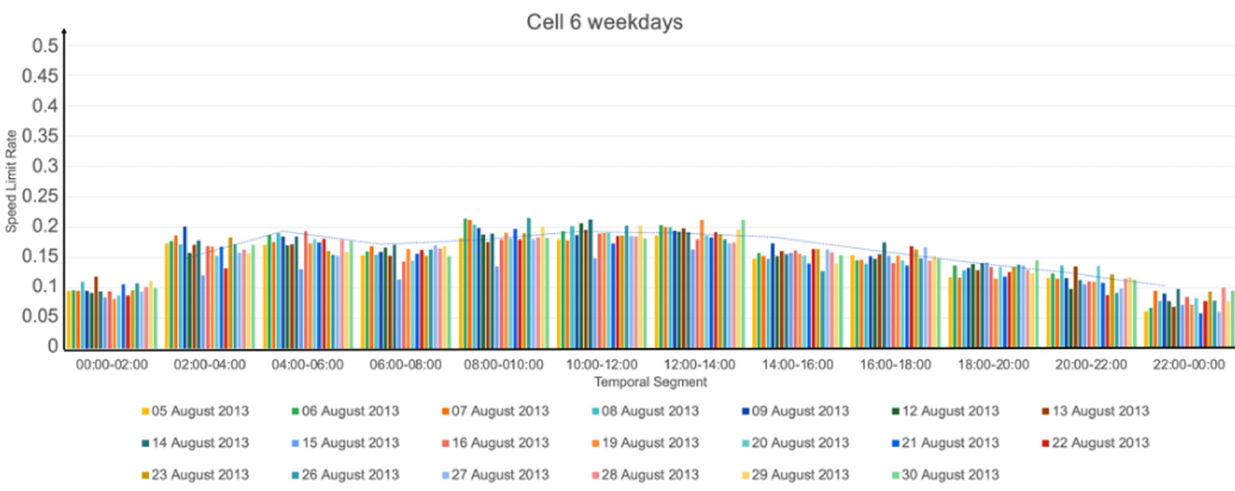
Figure A3. Results for the weekends, cell 6 with MaxSpeed = 30 km/h.